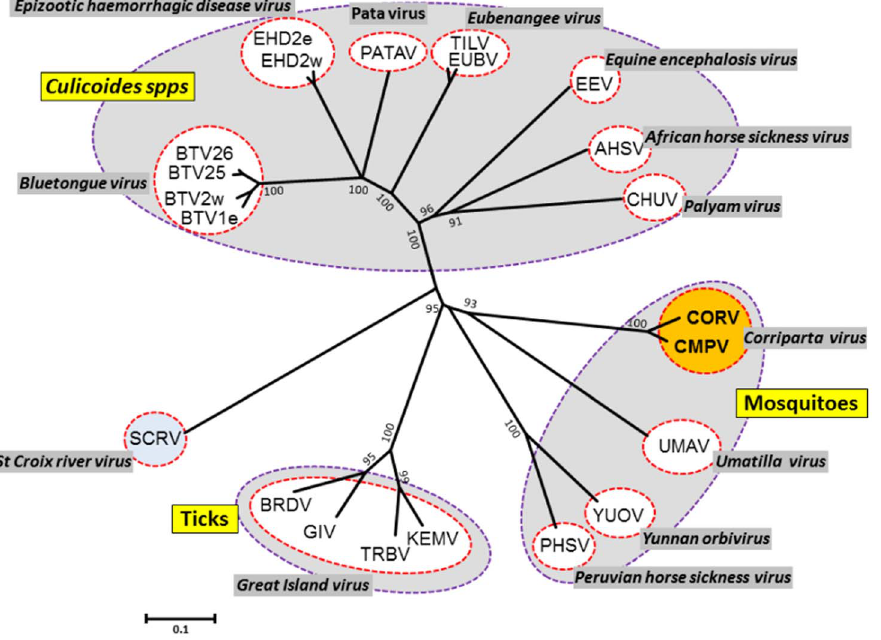
Figure 4. Unrooted neighbour-joining for orbivirus outer-core VP7(T13) proteins. An unrooted NJ phylogenetic tree for orbivirus VP7(T13) proteins was constructed using a p-distance algorithm and pairwise deletion parameters, as indicated in Figure 1. The CORV-MRM1 and CMPV isolates are shown in red font in amber coloured circle. Full names of virus isolates and accession numbers of T13 protein sequences used for comparative analysis are listed in Table S1 (supplementary data). ‘e’ and ‘w’ after serotype number indicate eastern and western strains, respectively.